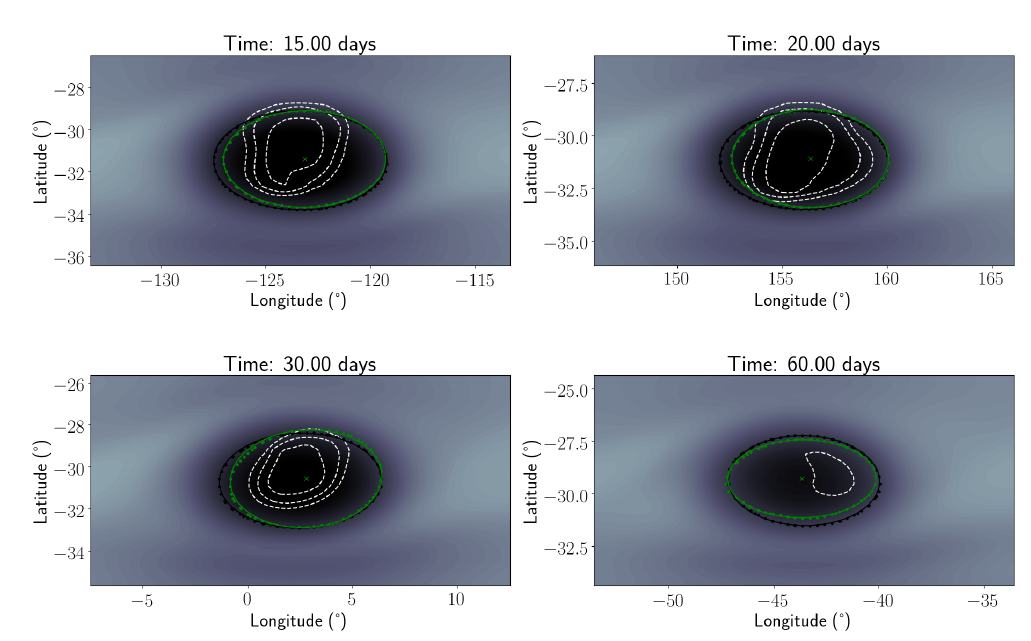
Figure 6. Dark spot defined by methane optical depth for Simulation 21. Elliptical vortex fits of closed potential vorticity contours at 500 hPa in green, of methane optical depth in black. The dashed white contours represent the cloud feature in terms of methane ice column density.